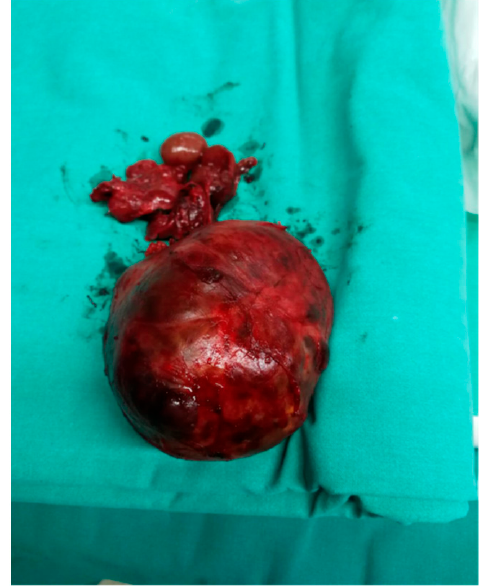
Figure 6. The thyroidectomy specimen.